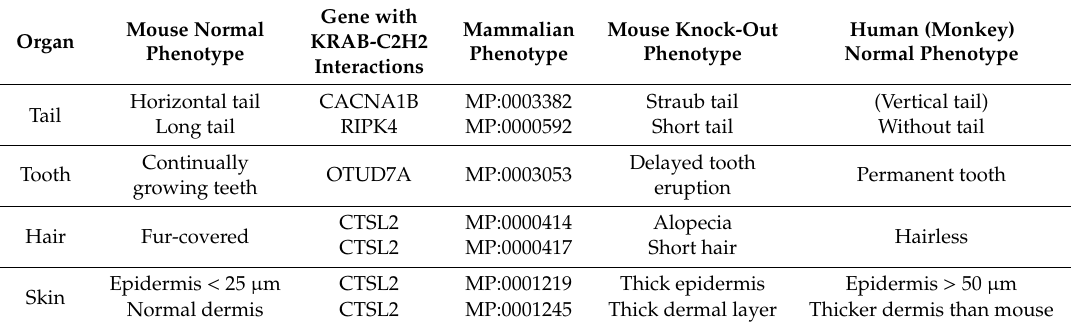
Table 2. Mammalian phenotypes of representative genes that interact with KRAB-C2H2 and have low expression in